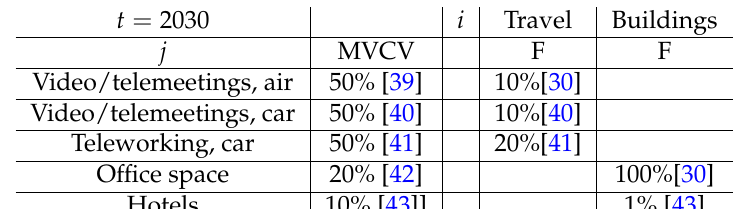
Table 11. Smart Services saving ICT